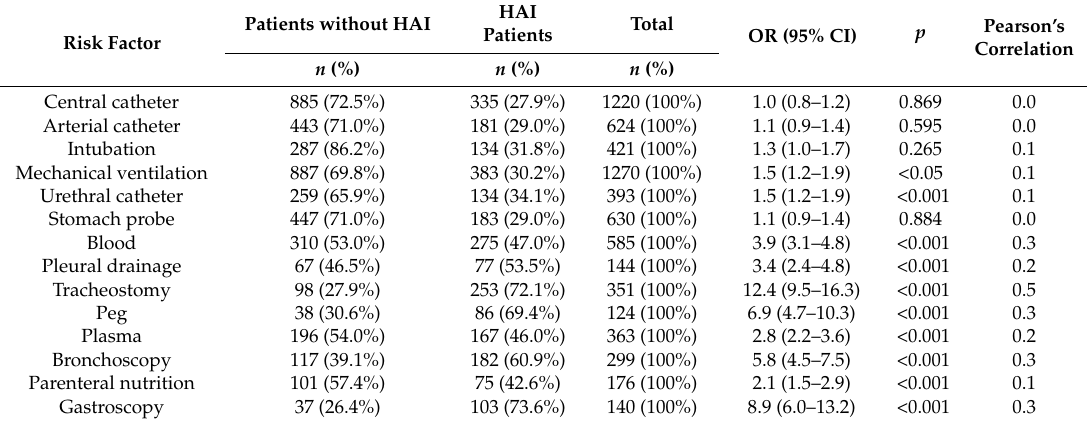
Table 2. HAI risk factors in the ICU, 2007–2016.